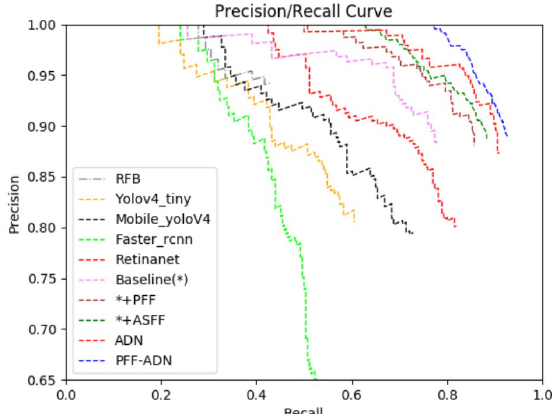
Figure 12. Precision-Recall curves of mentioned methods. (*) denotes the baseline